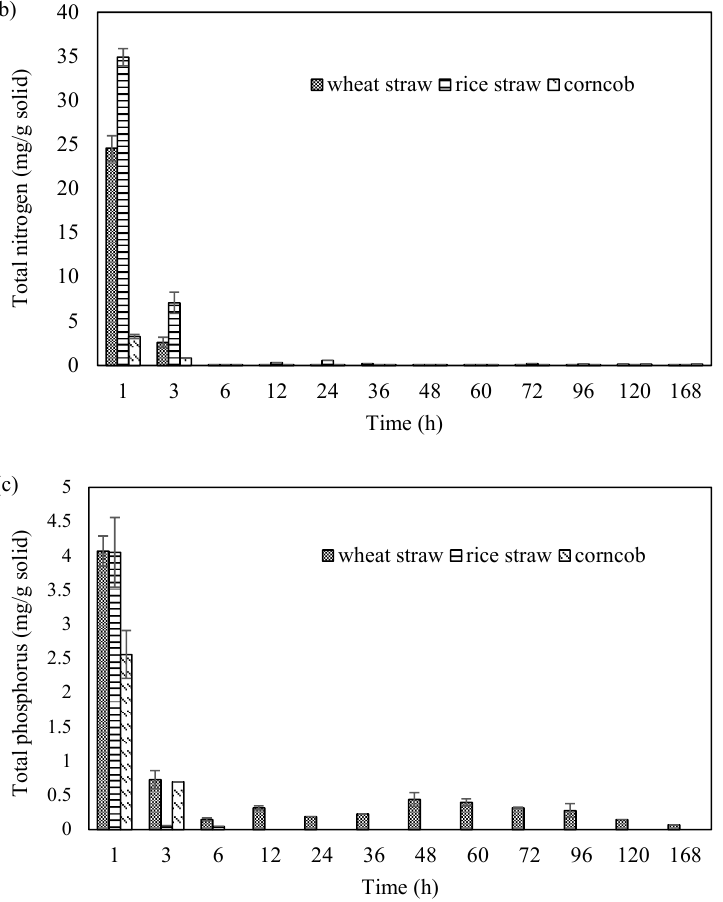
Figure 1. The carbon and nutrient release pattern of wheat straw, rice straw and corncob (( a ): the COD concentration variation; ( b ): the total nitrogen concentration variation; ( c ): the total phosphorus concentration variation).